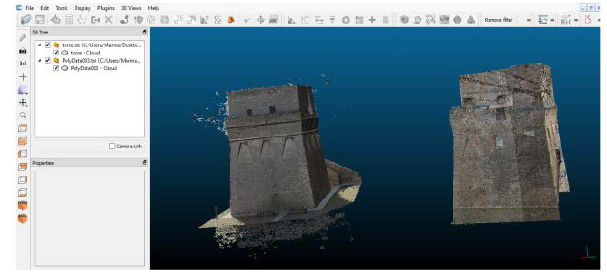
Figure 10: CloudCompare, point-cloud models